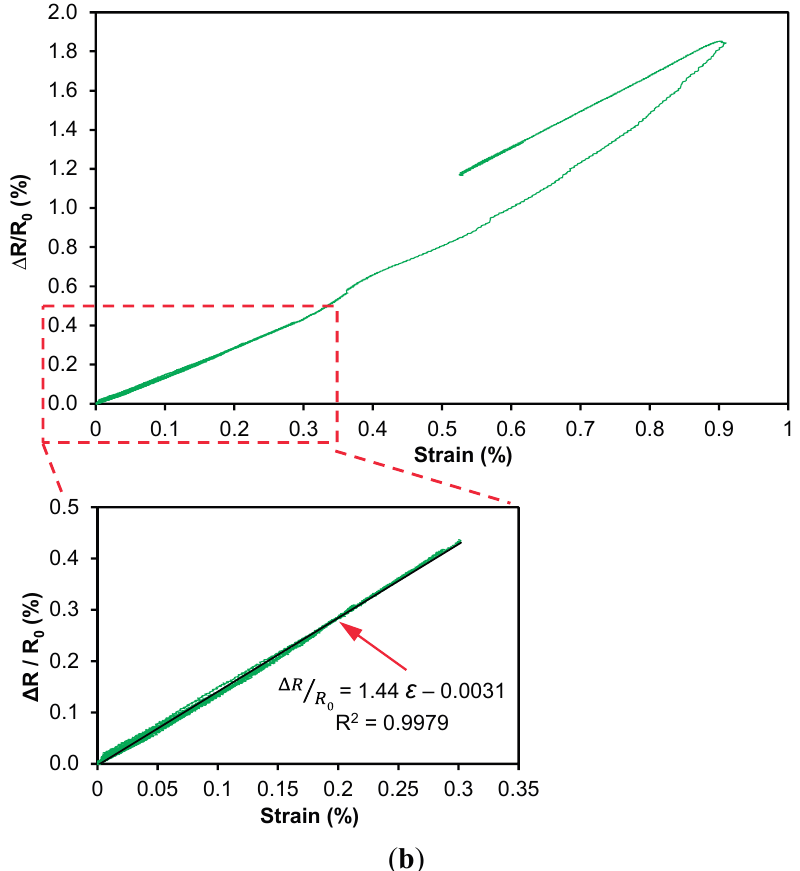
Figure 11. ( a ) Piezoresistive response of CNT-based composite sensing layer on Specimen Al-1.0%-CNT during the full cyclic loading test, showing the close tracking of strain and resistance up to plastic deformation of the specimen and ( b ) the resistance-strain response of the sensor (insert: elastic piezoresistive